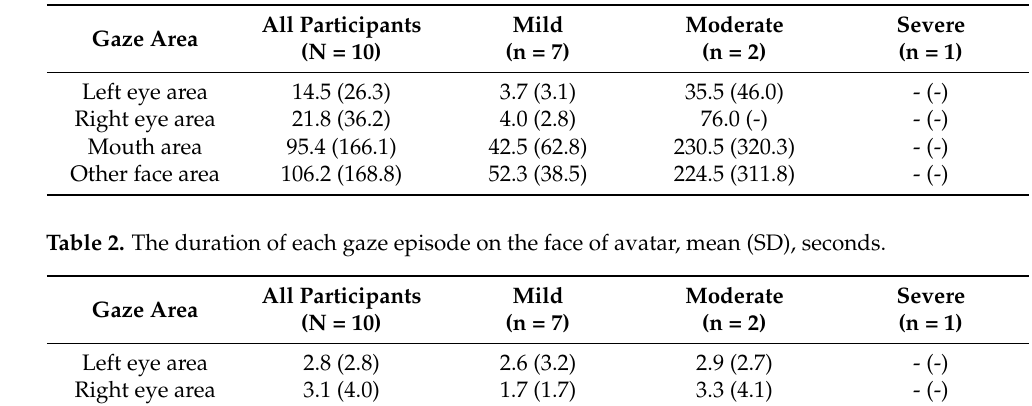
Table 1. The number of gaze fixations on the face of avatar, mean (SD). Gaze Area